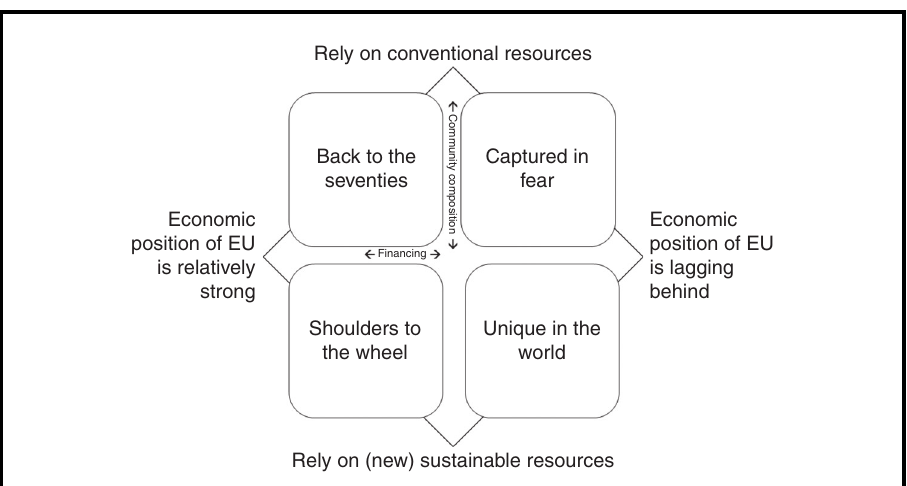
Figure 1 Framework with four scenarios for a sustainable tourism industry by 2040 Rely on conventional